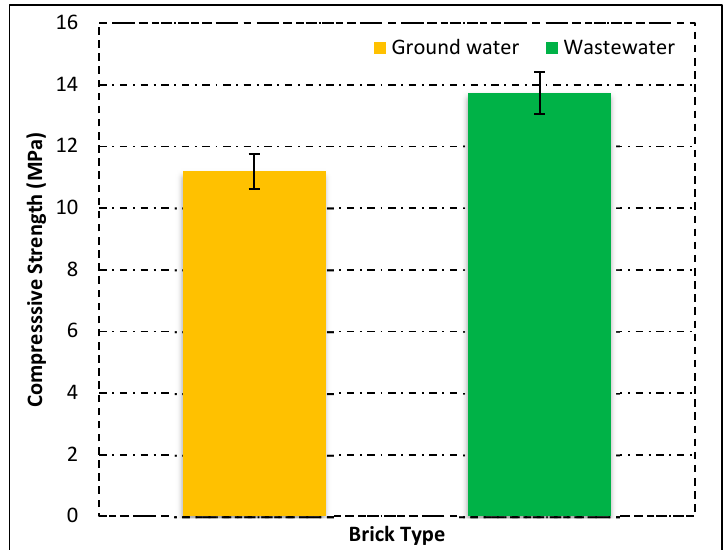
Figure 8. Compressive strength of fired clay bricks.